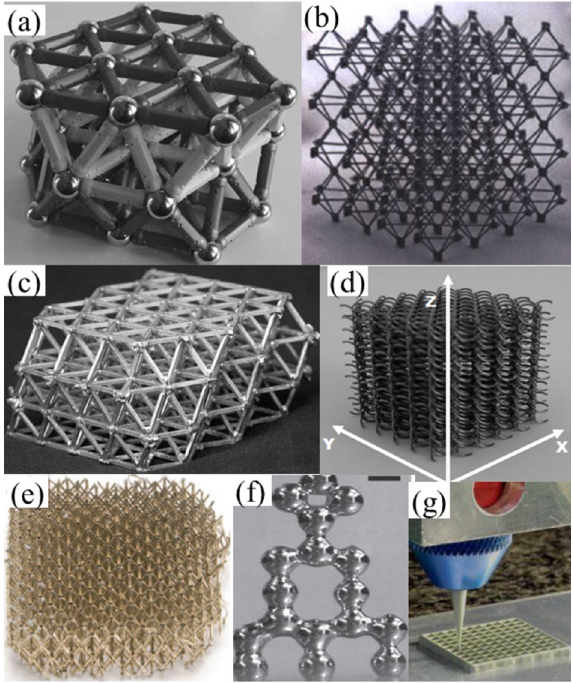
Figure 1. Multilayer lattice structure manufacturing technique ( a – b ) lattice (macro scale) building block assembly 10 ; ( c ) multi-stage manufacturing of pyramidal lattice sandwich 11 ; ( d ) Strucwire/Wire-woven with 0.63 mm steel wire 12 ; ( e ) Ultralight micro-lattice (5 cm length) with electroless nickel plating 13 ( f ) liquid metal drop 0.5 mm scale 14 ( g ) direct write 200 µm nozzle 15